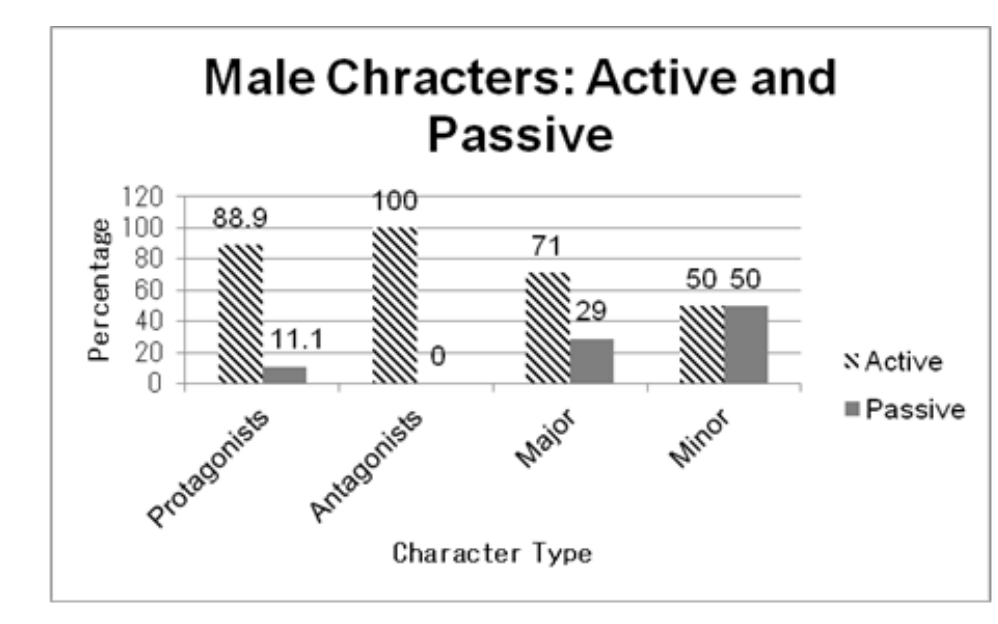
Males divided by overall activeness or passiveness. This chart is very similar to Figure 2 in its results. Traditional and progressive male and female roles for the characters were evaluated throughout each of the stories. Distinct exhibitions of roles and traits on part of a character’s development or part in a story were recorded for each class of character. Individual traditional and progressive roles for males and females are listed within Figures 4, 5, 8, and 9; for males, nine traditional roles (Figure 4) and two progressive roles (Figure 5) were examined for occurrences and for females, nine traditional roles (Figure 9) and five progressive roles (Figure 8) were examined for occurrences. Males have a stronger portrayal of traditional roles (91.4%, n=74) than progressive roles (8.6%, n=7) (Figure 6). Of the traditional traits for males, independence (37.8%, n=28) and aggression (28.3%, n=21) are the most highly featured, with the remaining 33.9% (n=25) representing all of the other traditional role observations (Figure 4). The protagonists show the highest instances of independence and bravery in any male character category. Male characters infrequently exhibited progressive traits; those who exhibited progressive traits were most often caring at 85.7% (n=6) and infrequently emotional or willing to share emotions at 14.3% (n=1) (Figure 5). Males more often exhibit traditional roles than progressive roles at a ratio of approximately 10:1 (Figure